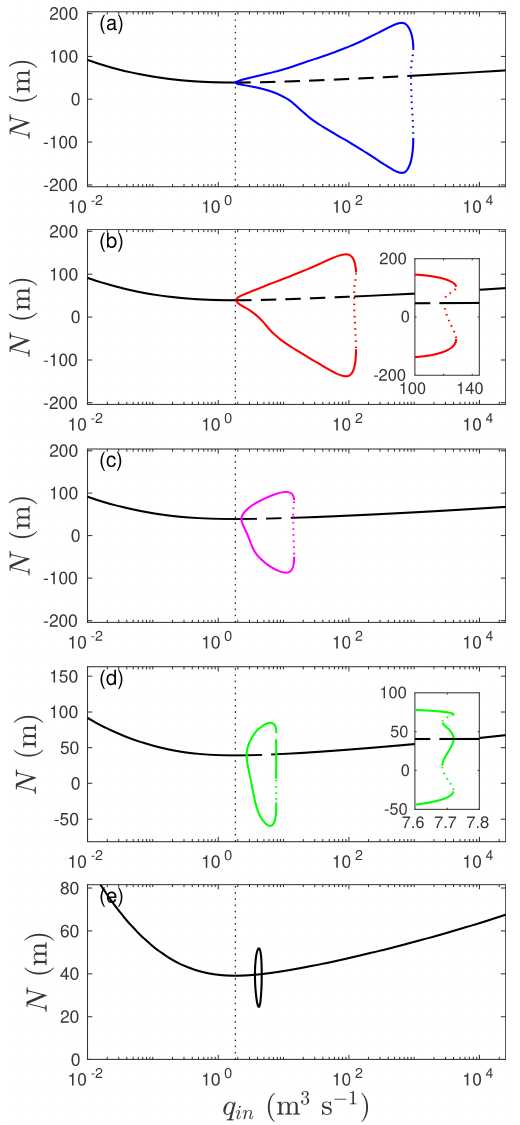
Figure 5. Bifurcation diagrams for L = 50km and V p = 4 (a) , 0.8 (b) , 0.16 (c) , 0.112 (d) , and 0.094 (e) km 2 . Plotted are stable (solid black) and unstable (dashed black) steady-state N , as well as minimum and maximum N attained in stable (solid coloured) and unstable (dotted coloured) periodic solutions. The insets in (b) and (d) show details, while the vertical dotted line marks the value of q in at which the conduit becomes channel-like.